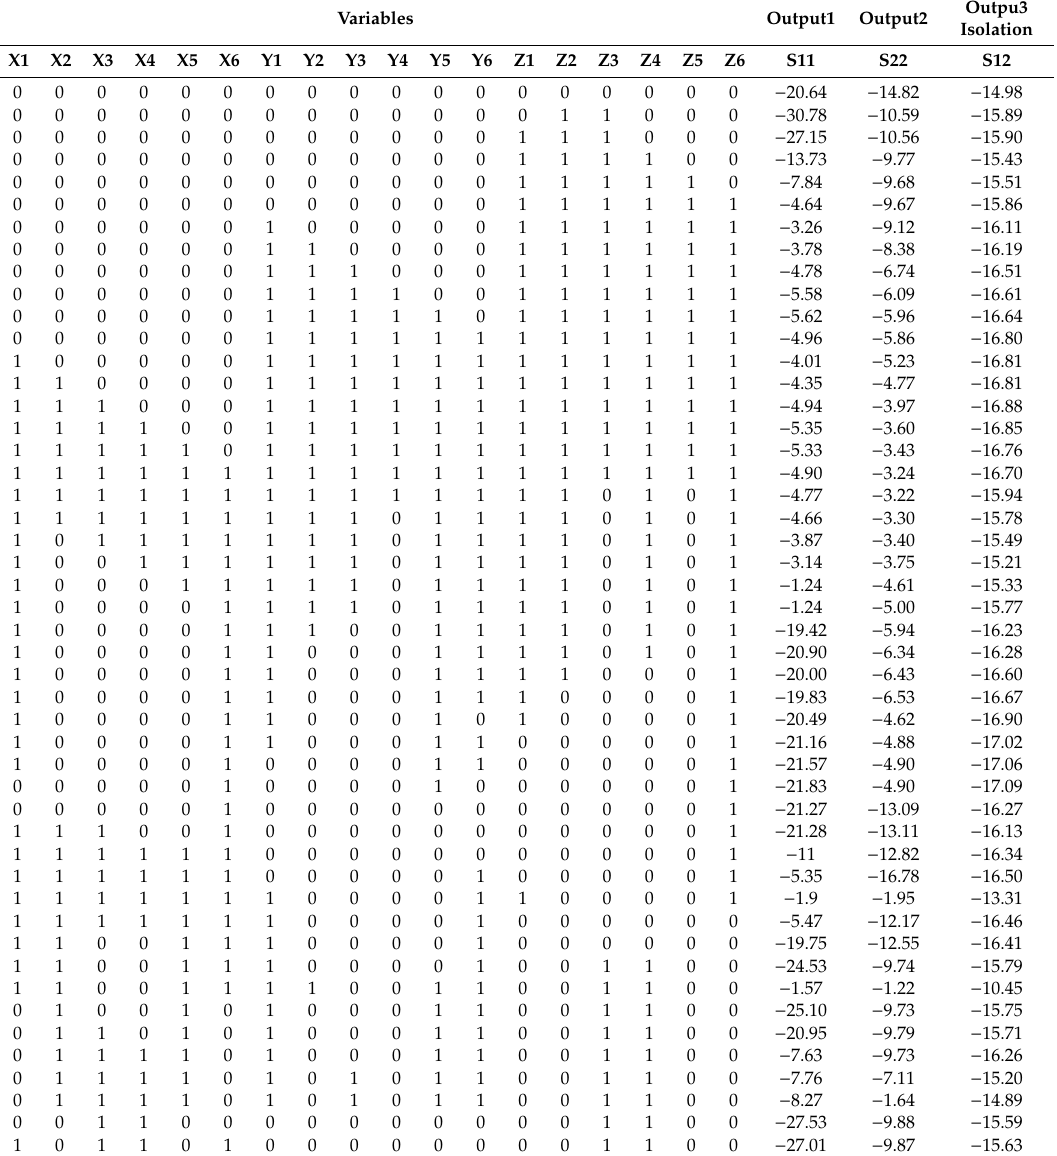
Table 1. Return loss and transmission values of 48 various resonator planes.